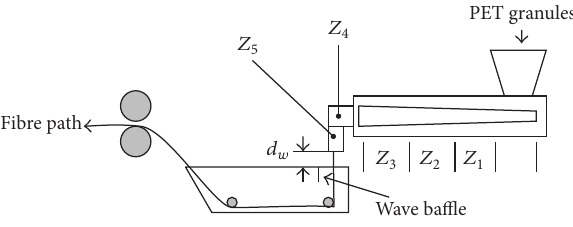
Figure 1: Schematic of single-screw extrusion line for preparation of as-spun precursor PET monofilaments.